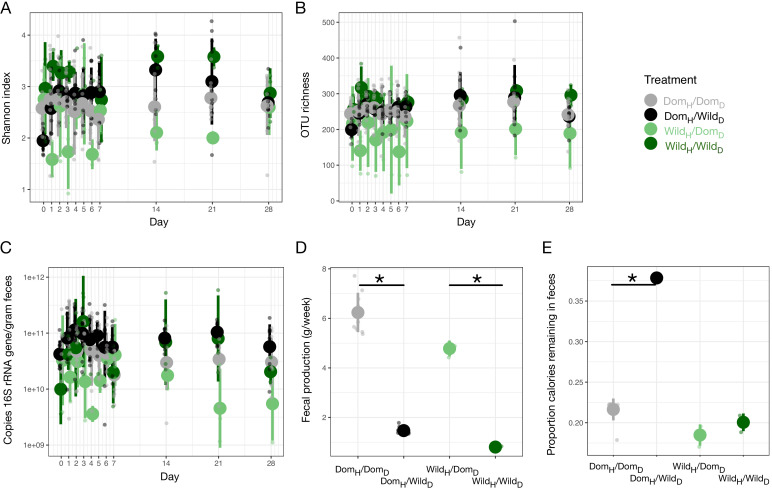
Select microbial and host metabolic parameters under mouse diet swap.(A) Shannon index by experimental groups over time.(B) OTU richness by experimental groups over time. (C) Microbial load by experimental groups over time. (D) Total fecal production over 1 week differs between experimental groups. (E) Calories remaining in feces as a function of total calories consumed varies by diet in DomH mice. * in (D) and (E) indicates p<0.05, Mann–Whitney U test. Large circles are means; bars show standard deviations.